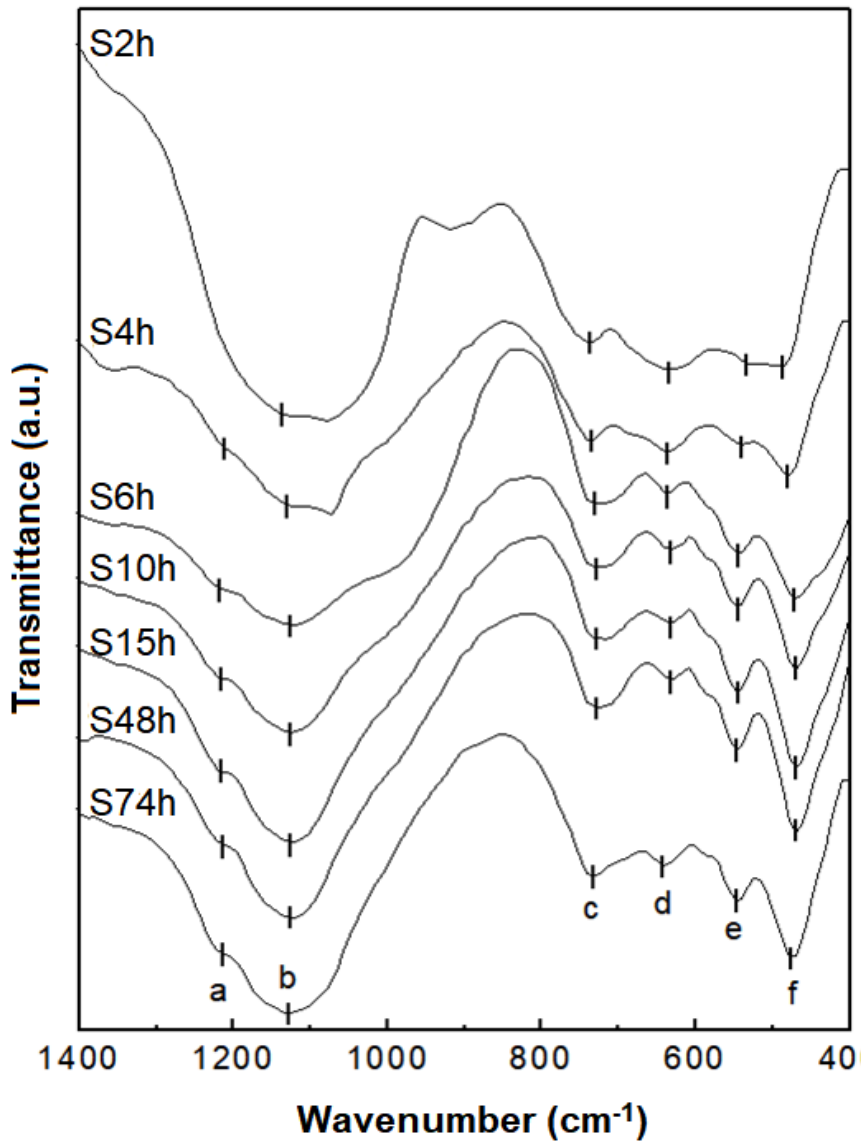
Figure 4. Infrared spectra of the samples obtained during the crystallization of AlPO 4 -11, at different synthesis times. The absorption bands (e) and (f) were used for determination of the crystallinity. Table 1. Wavenumbers and assignments for the main absorption bands of the infrared spectra of the ALPO-11. Internal Tetrahedra External Tetrahedra Vibration Wavenumber (cm − 1 ) Vibration Wavenumber (cm − 1 ) Asymmetric stretch (b) 1250–950 Asymmetric stretch (a) 1050–1150 Sh Symmetric stretch (d) 720–650 Symmetric stretch (c) 750–820 Bend (T-O) (f) 420–500 Double ring (e) 650–500 Sh Shoulder; the letters in parentheses indicates the position of the bands in Figure 4.